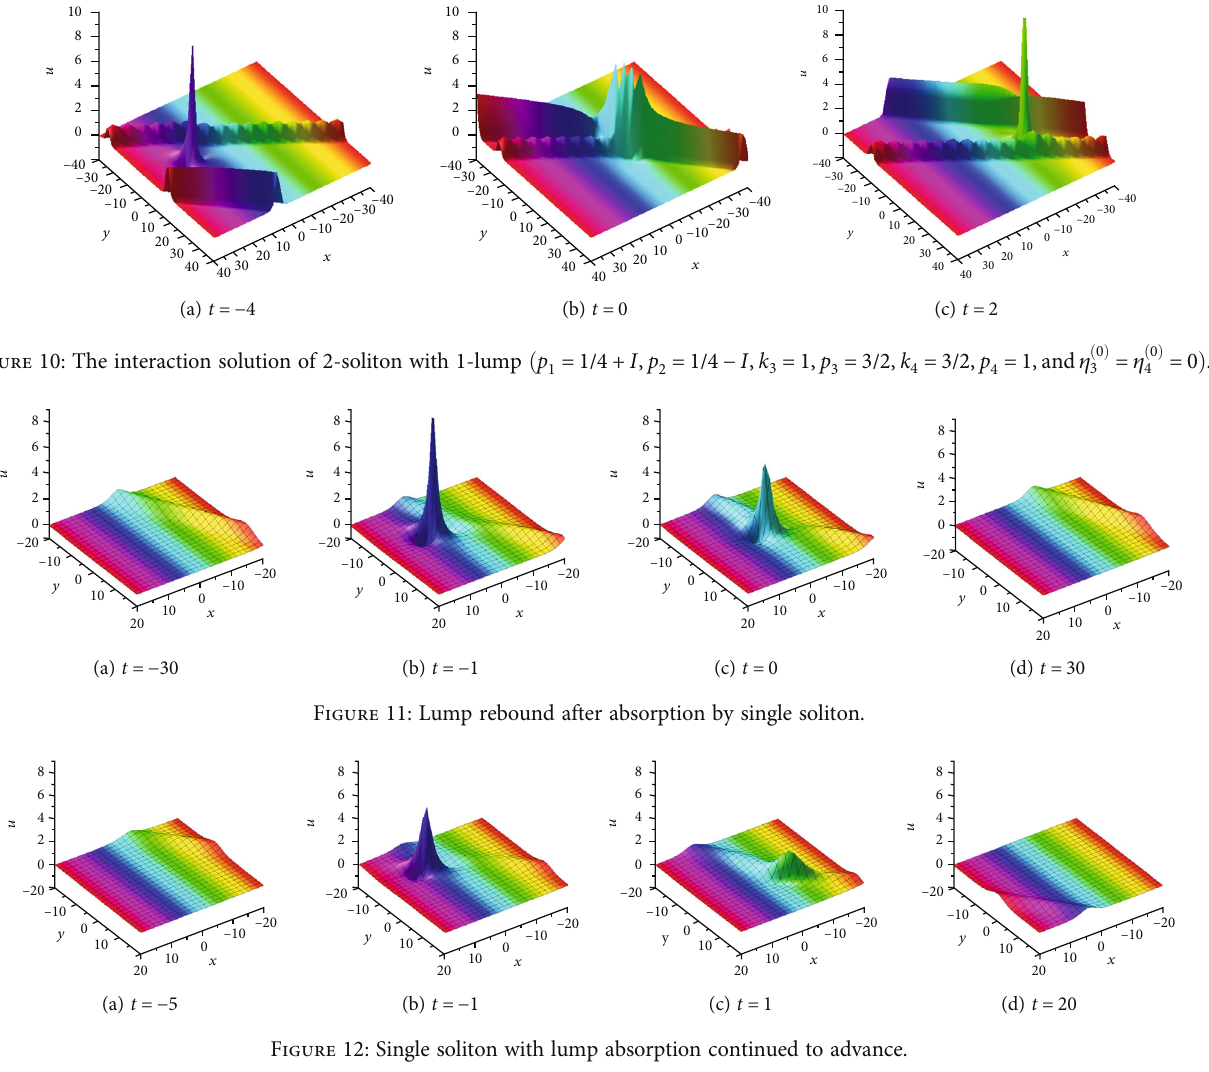
Figure 12: Single soliton with lump absorption continued to